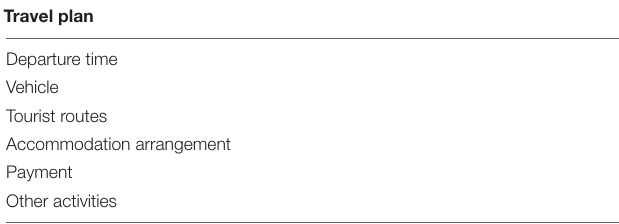
TABLE 3 | Content clues for a travel